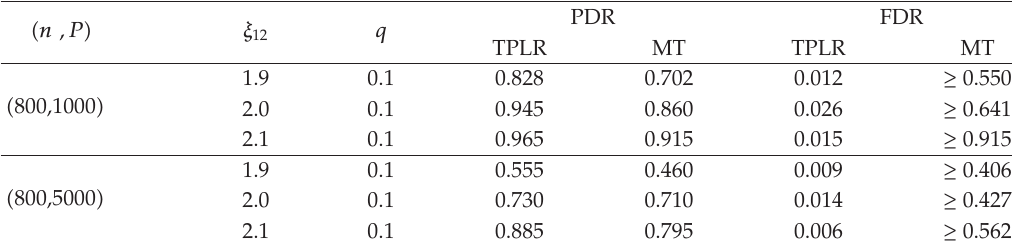
Table 5: The simulated average PDR and FDR under Model 4: significant interaction e ff ect but zero marginal e ff